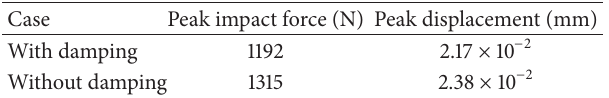
Table 1: Comparison of impact forces and deformations of pound- ing model with and without damping.